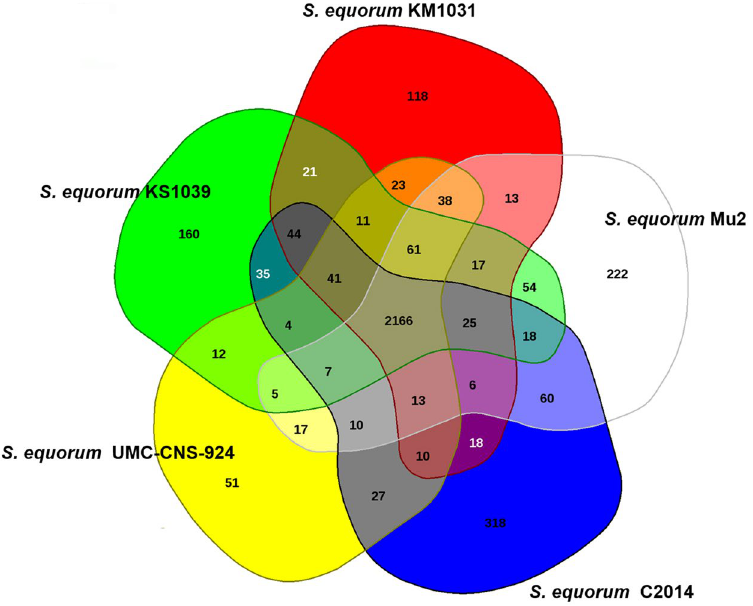
Figure 2. Venn diagram of five S . equorum genomes. The Venn diagram shows the pan-genome of strains KM1031, C2014, KS1039, Mu2 and UMC-CNS-924 generated using EDGAR. Overlapping regions represent common CDSs shared between the S . equorum genomes. The numbers outside the overlapping regions indicate the numbers of CDSs in each genome without homologs in the other sequenced S . equorum